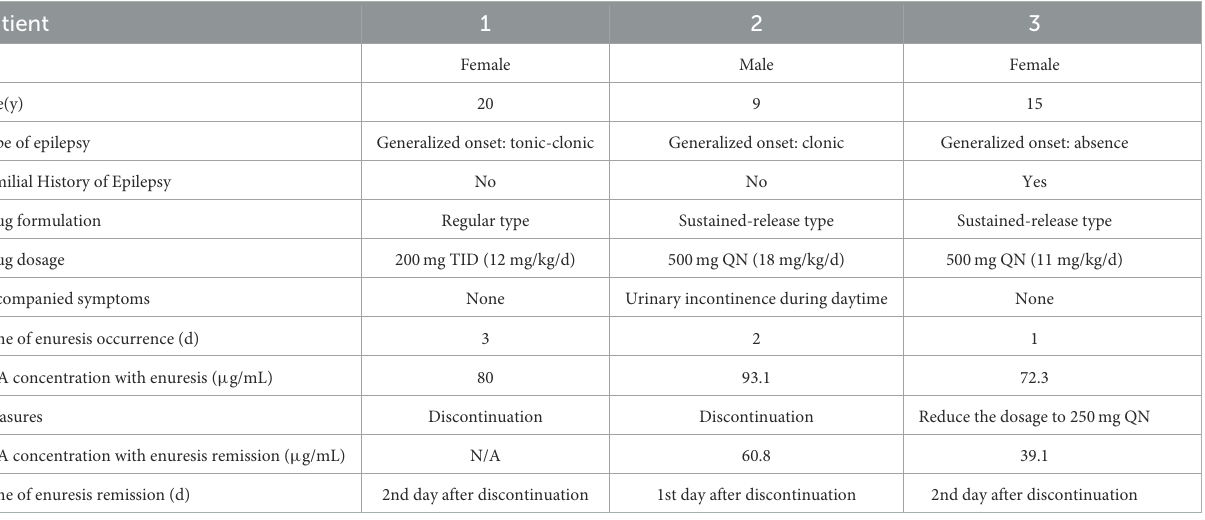
TABLE 1 Clinical data of three unpublished case